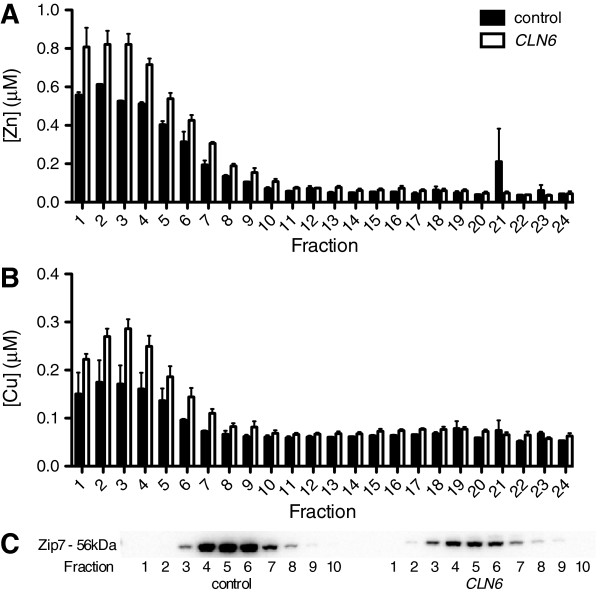
Biometals accumulate in subcellular fractions that display Zip7 loss in presymptomatic CLN6 sheep occipital lobe. Sucrose density gradient fractions from 3 month old sheep occipital lobe were analyzed for metal content by ICP-MS. Data are expressed as the mean + SEM of Zn (A) and Cu (B) concentrations in CLN6 brains (white bars throughout) and control brains (black bars throughout) from 3 individual sheep per genotype. (C) Representative immunoblot of Zip7 protein present in fractions from control and CLN6 affected sheep brains.